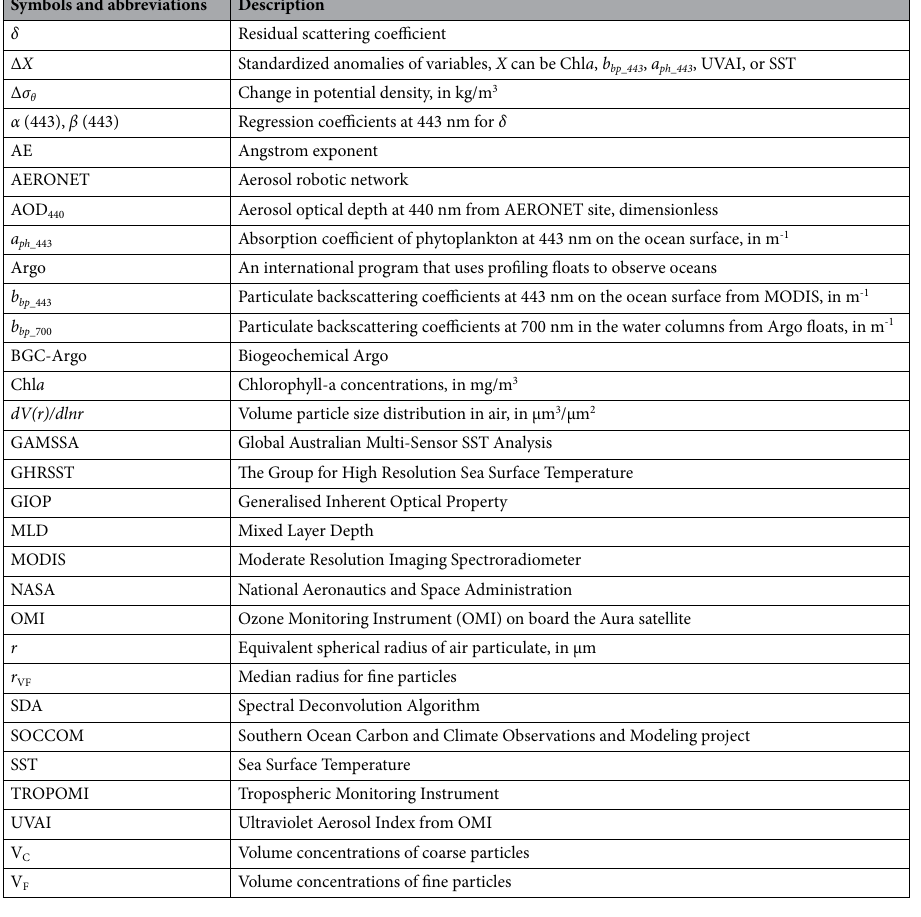
Table 1. Symbols, terms, definitions and